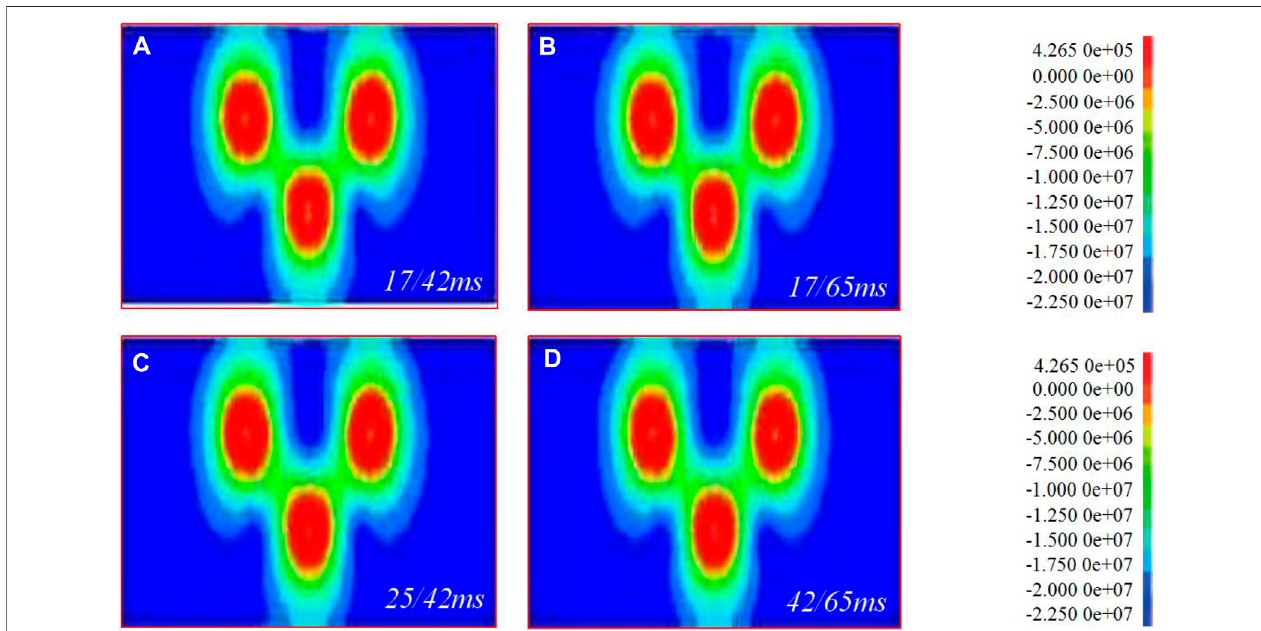
FIGURE 9 | 9 × 3 model 200 ms equivalent stress superposition. (A – D) are the superposition of equivalent stresses of 17/42 ms, 17/65 ms, 25/42 ms and 42/ 65 ms, respectively.